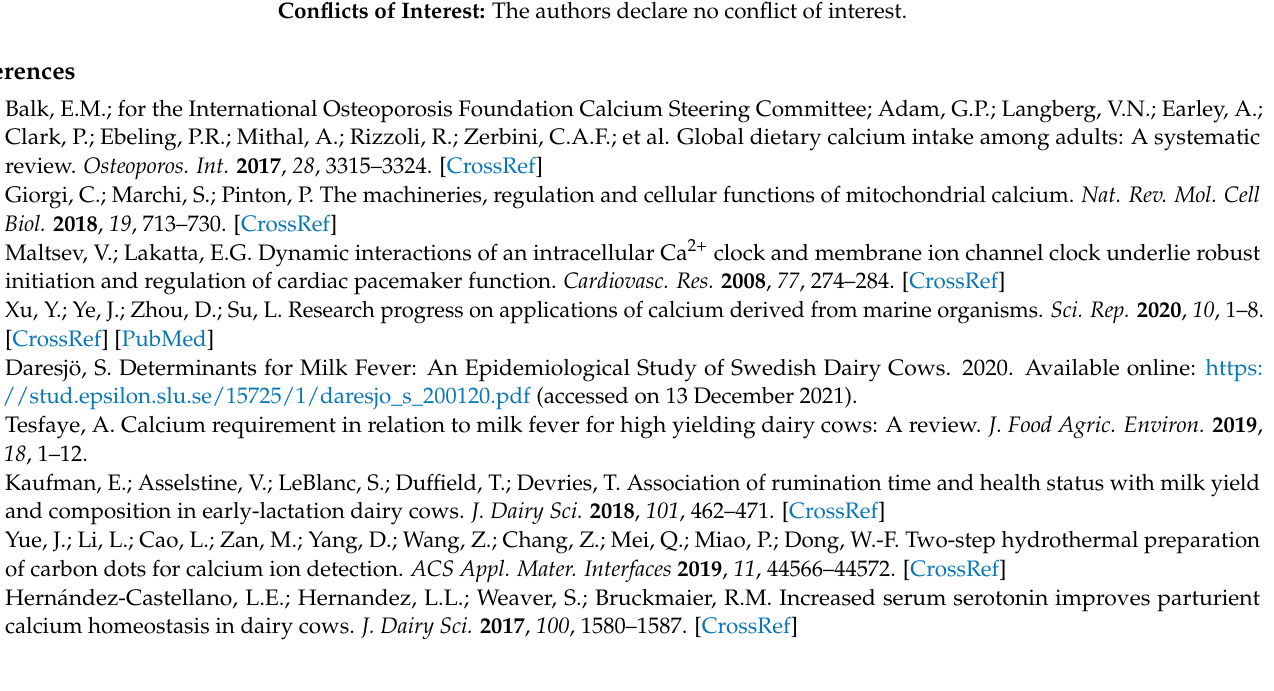
equivalent circuit, Figure S3: predicted Ca 2+ concentration against true Ca 2+ concentration using the stepwise linear regression, Figure S4: overall structure of the NNF model with the LM algorithm, Figure S5: predicted Ca 2+ concentration against true Ca 2+ concentration using the established NNF model, Figure S6: predicted Ca 2+ concentration against true Ca 2+ concentration using the established GPR model, Table S1: Related indexes in dairy